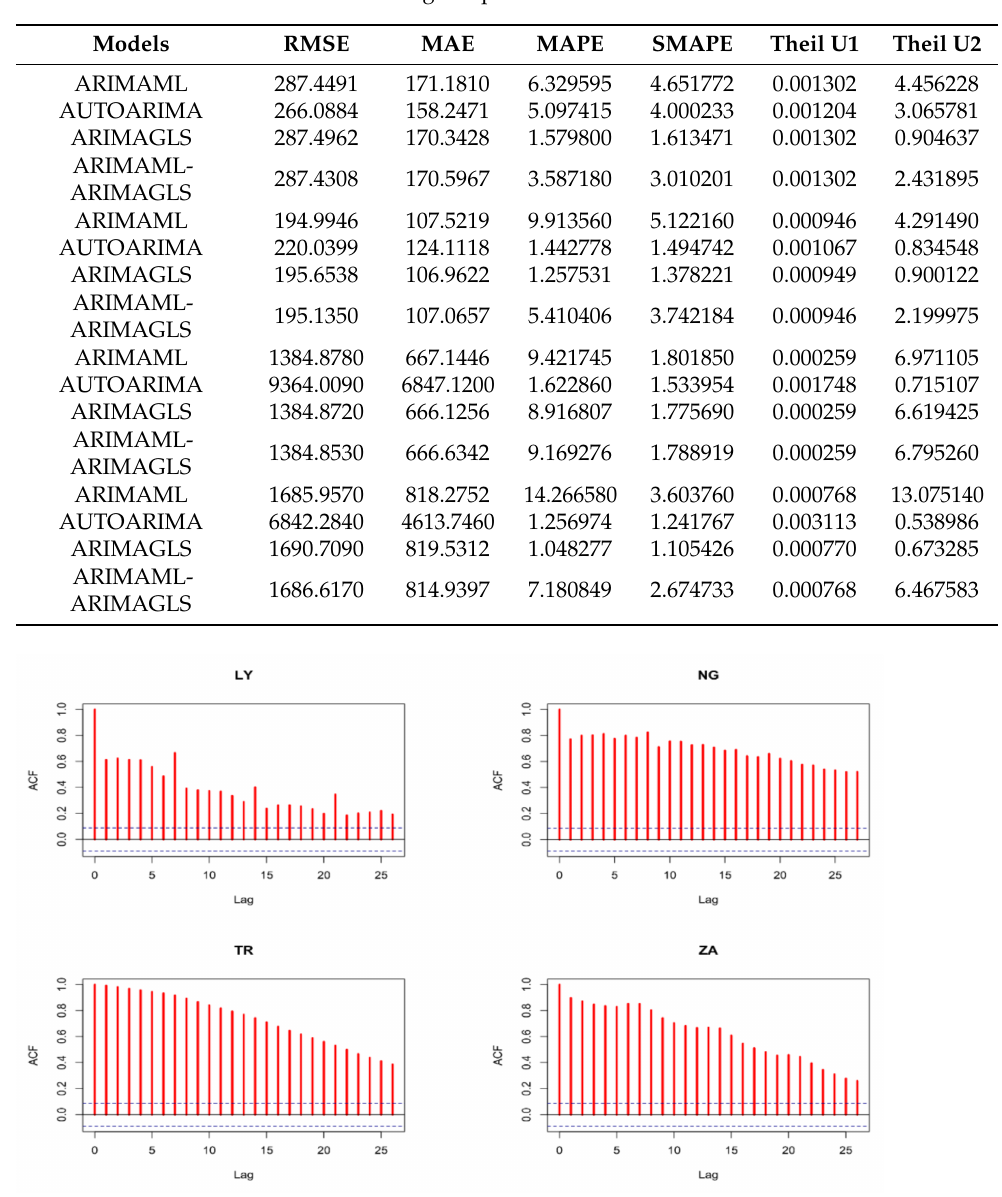
Figure 8. ACF of the first difference of CCC for the four